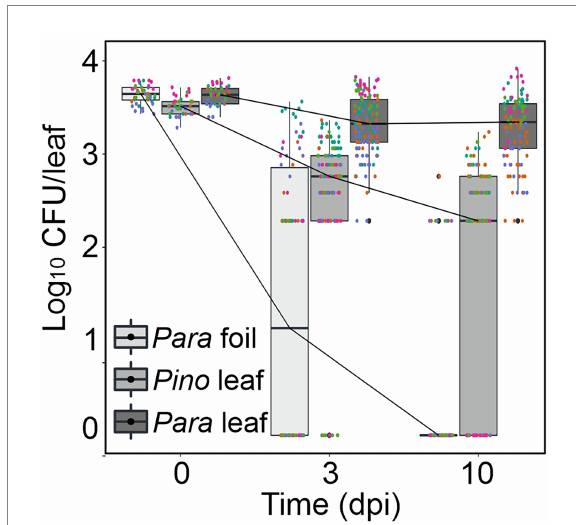
FIGURE 2 Protomyces arabidopsidicola strain C29 persistence on Arabidopsis . Persistence assay of P. arabidopsidicola (Para) and P. inouyei (Pino) on the surface of Arabidopsis leaves aseptically grown on 0.5 x MS agar. Cells were re-isolated from drop inoculated plants at the indicated times and plated to determine cell numbers, which are presented as the number of colony forming units (Log 10 CFU/leaf). Persistence on sterile foil was used as a control for the ability to survive non-specifically on surfaces. Pooled data from five independent biological repeats (n = 25) were analyzed by computing a linear mixed model in R (v3.5.1). The pooled data is displayed in standard boxplots, all data points are plotted with a different color for each independent biological repeat.